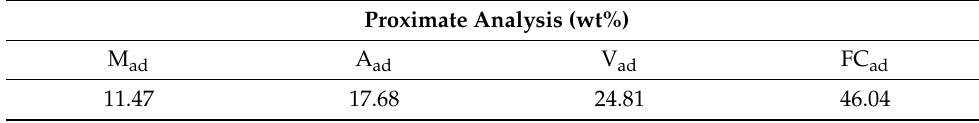
Table 1. Proximate analyses of the coal (ad: air dry